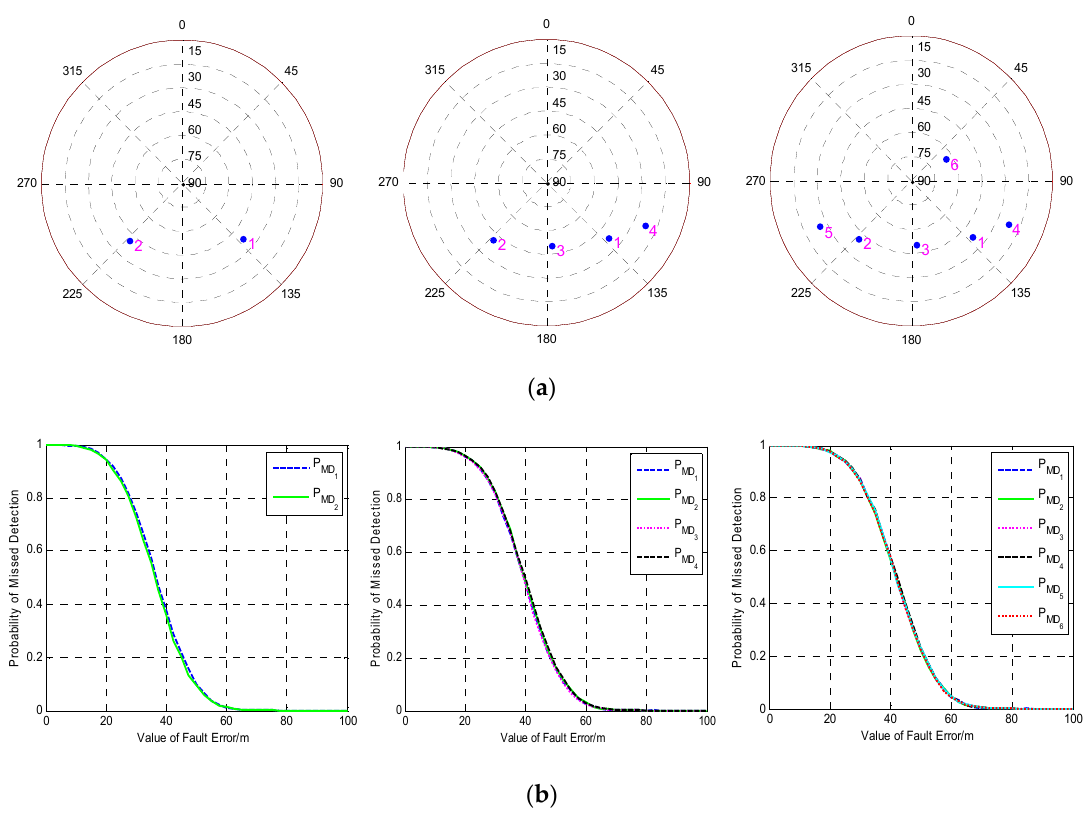
Figure 5. The fault detection results under two, four, and six visible satellites. ( a ) Sky plot views of the satellite geometries; ( b ) The probabilities of missed detection under different alternative hypotheses as a function of fault error.